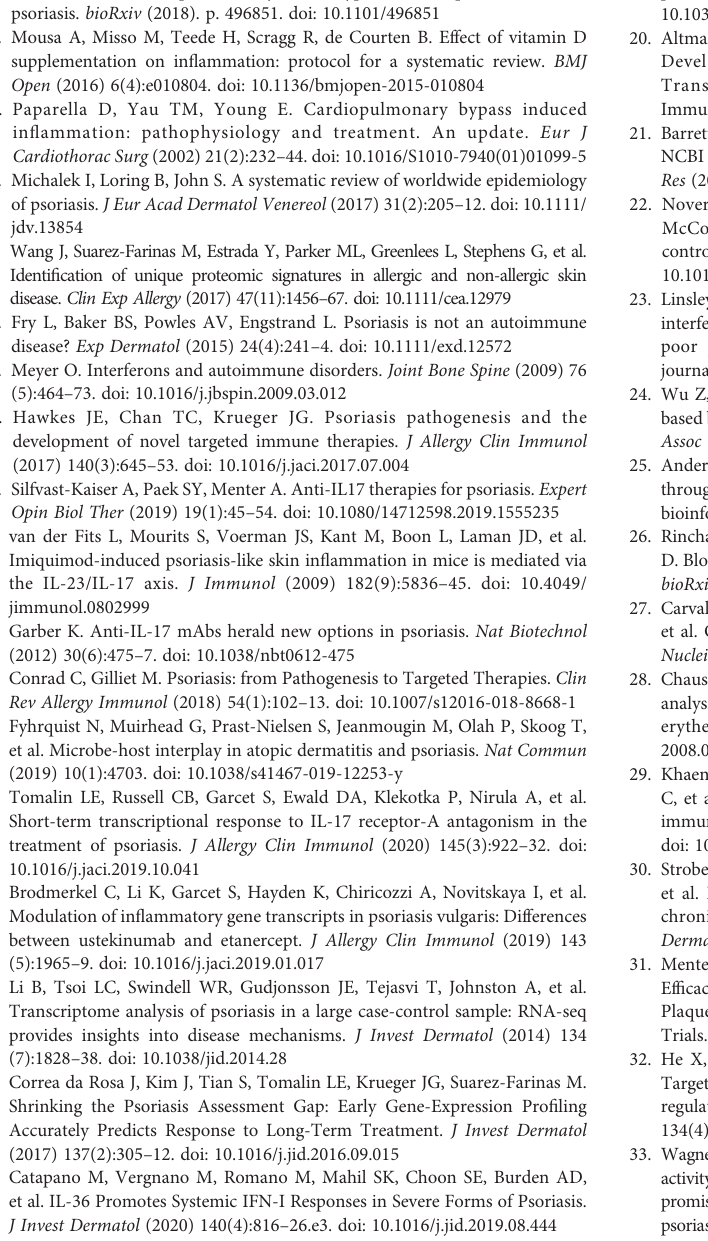
controls shown in Figure 1 . Each position on the grid corresponds to a different module. Each of the 382 modules are constituted by a set of transcripts found to be co-expressedacrossarangeofdiseaseandphysiologicalstates.Inturn,themodules are arranged in rows based on similarities in gene expression. Gene ontology, pathway or literature keyword enrichment analyses provide the basis for attribution of biological functions to the modules; these are indicated by the color-coded abbreviations list below the grid. An interactive presentation is available that permits the exploration offunctional enrichment results and expression patterns for the A35 modules: